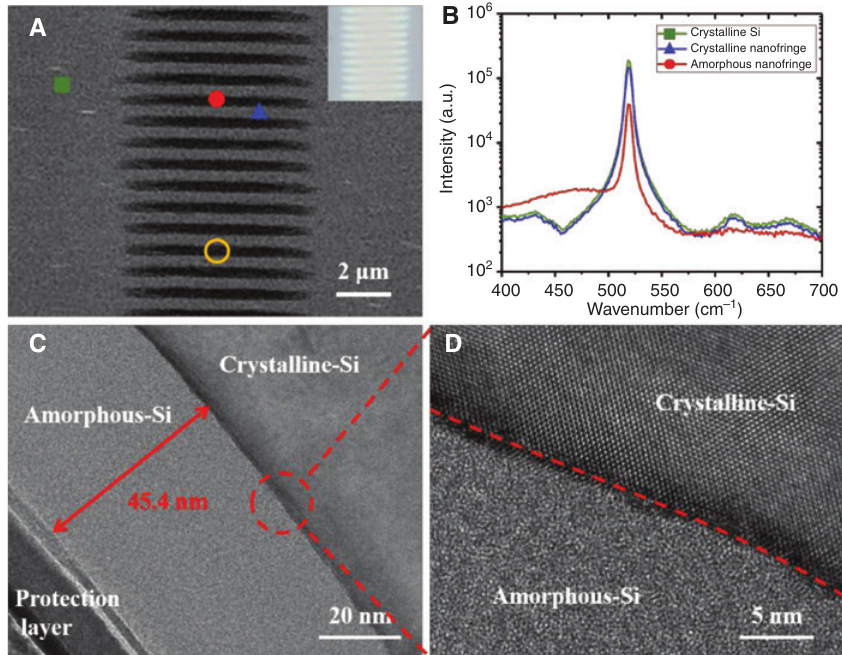
Figure 2: Processing and analysis of amorphous-silicon nanofringes. (A) SEM micrograph of the modified nanofringes on Si wafer produced by femtosecond laser scanning through the sample with a constant = 2000 μ m s −1 , using laser fluence F = 167 mJ cm −2 . (B) Raman spectra corresponding to the marked positions in (A). The red velocity v scan circle, blue triangle, and green square marked in (A) represent the position of amorphous-Si nanofringe, crystalline-Si nanofringe, and non- irradiation zones, respectively. The colors of the Raman spectra in (B) correspond to the marks in (A). (C) TEM image of the laser-modified region marked by a yellow circle in (A). (D) A partial enlarged view of